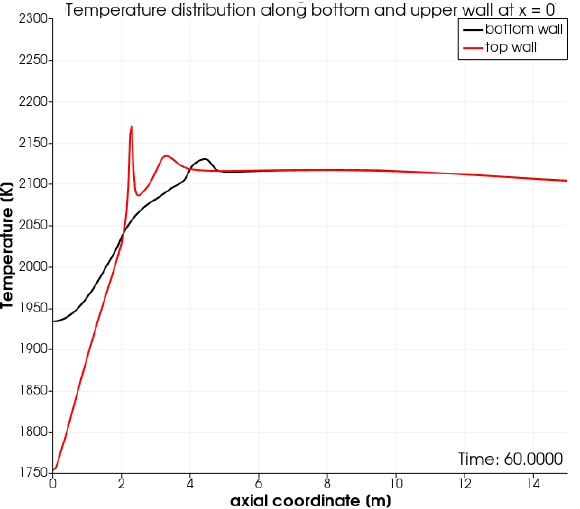
Figure 3. Temperature along the first 15 m along the top and bottom wall of the